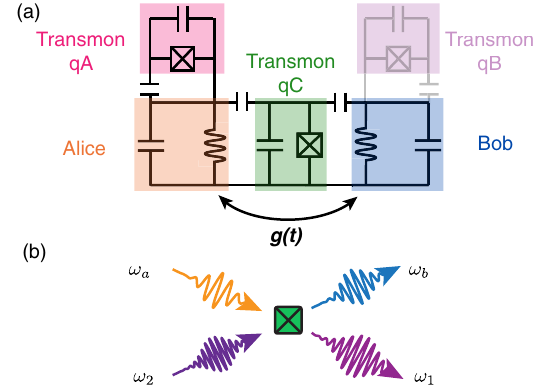
FIG. 1. cQED system. (a) The effective circuit of the cQED system containing two high- Q harmonic oscillators (orange, blue) bridged by a transmon (green), as well as an additional transmon mode (pink) that only capacitively couples to Alice. A similar ancillary transmon (purple) can also be used, but it is not necessary for this experiment. The resonance frequency of Alice and Bob are detuned from each other by ∼ 1 GHz to minimize undesired cross talk. (b) Four-wave mixing process through the Josephson junction of qC that enables the bilinear coupling between Alice and Bob when ω 2 − ω 1 ¼ ω